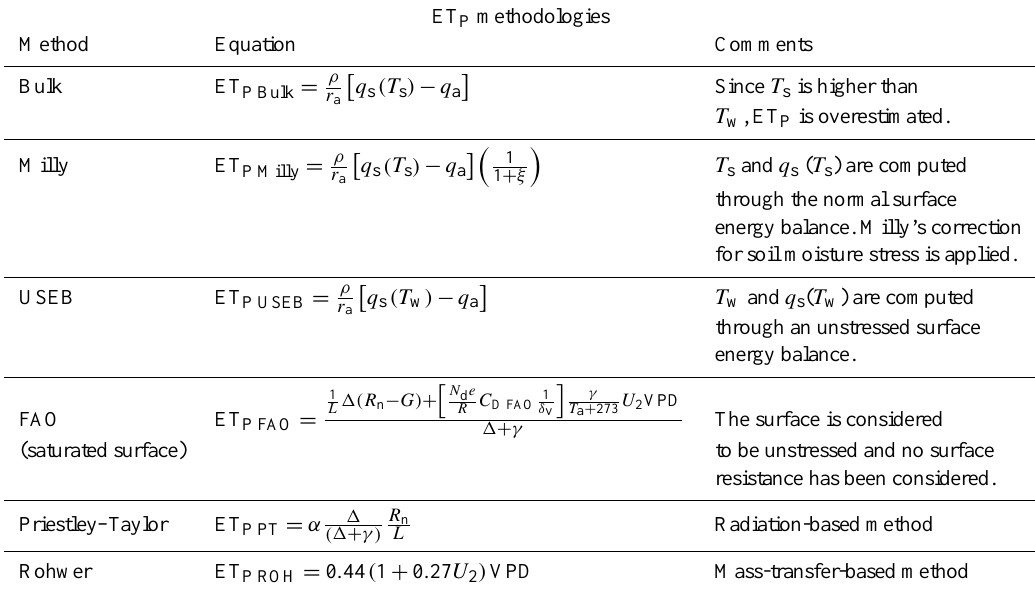
Table 1. The different methodologies used in this study to compute ET P .